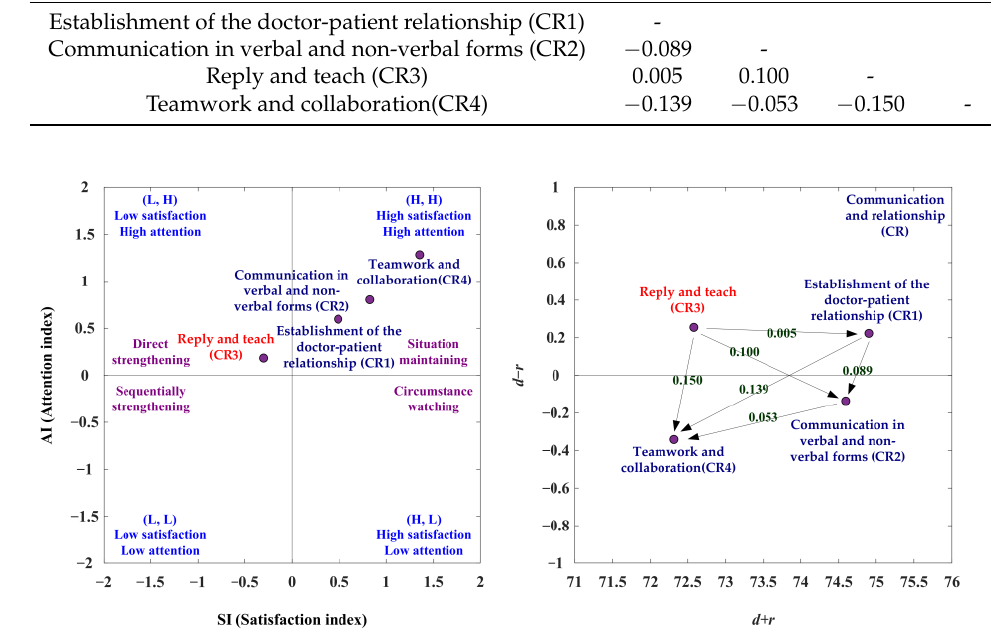
Figure 5. The SDM competency development map for communication and relationship (CR) as- pect. Table 12. The development strategies of the communication and relationship (CR) aspect.